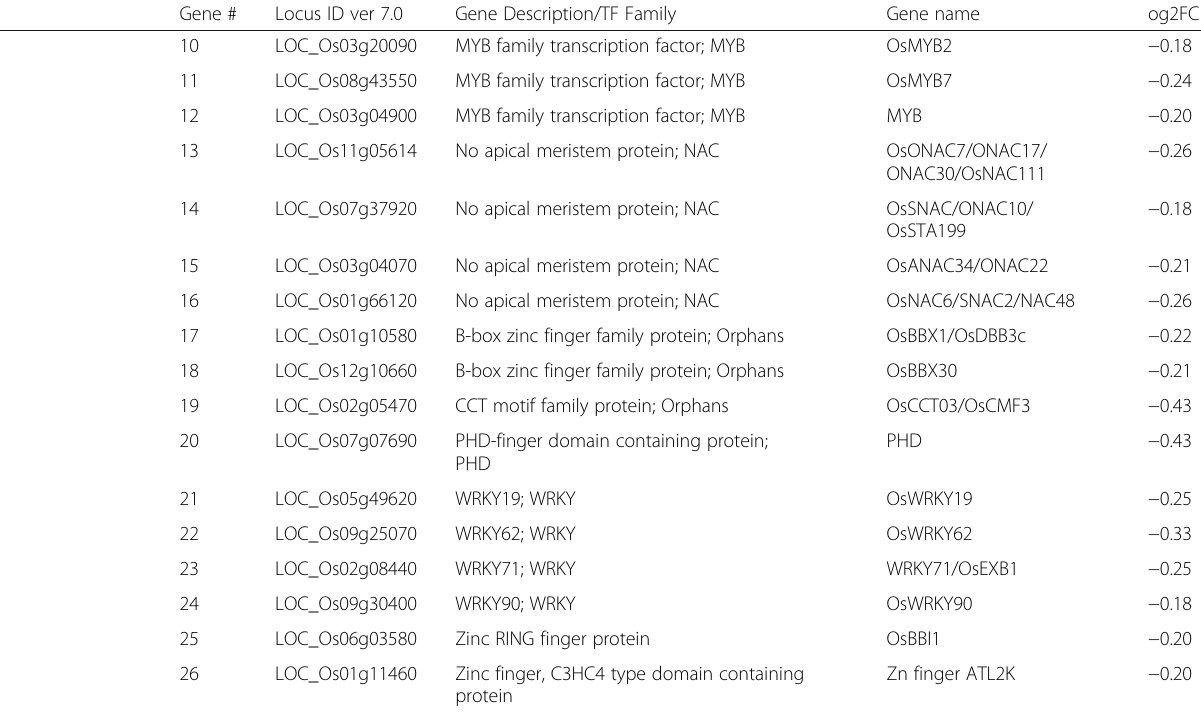
Table 2 Details of the differentially expressed TF genes and their corresponding fold change value (log2FC) under submergence in IR64 and IR64-Sub1 (Continued)